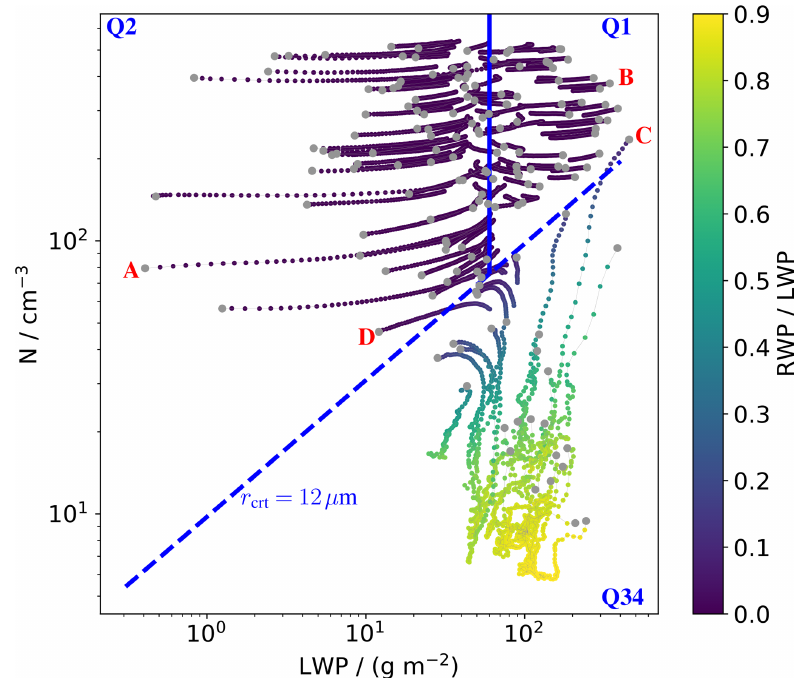
Figure 1. Temporal evolution (hours 2–12) of 159 LESs with varying initial conditions (see text) in an LWP– N state space, colored by fraction of rain water path (RWP) to the total liquid water path (LWP). Individual simulations are indicated by gray lines and start at the location of gray circles. The dashed blue line corresponds to an adiabatic volume-mean droplet radius at cloud top of 12µm (adiabatic condensation rate γ = 2 . 5 · 10 − 6 kgm − 4 ). Together with the solid blue line, it defines three regions, which are labeled Q1 (first quadrant), Q2 (second quadrant), and Q34 (combination of third and fourth quadrants). Red letters indicate trajectories discussed in the main